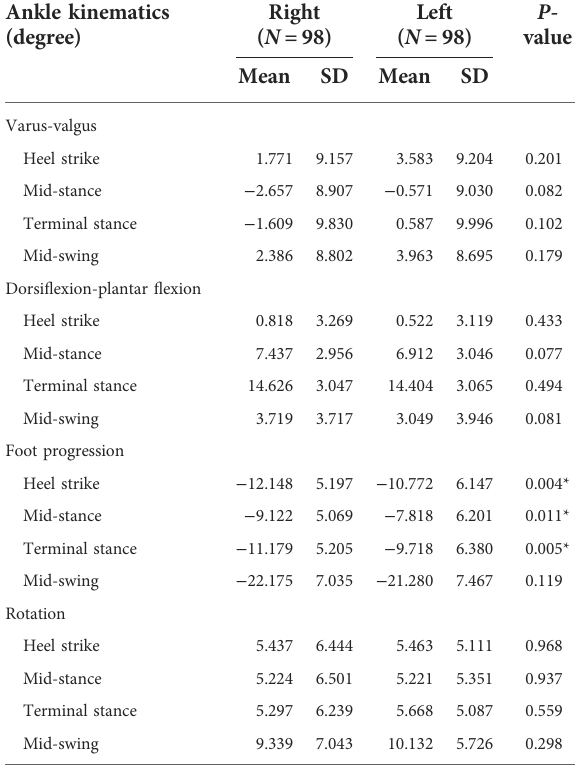
TABLE 2 The comparison of ankle kinematics between